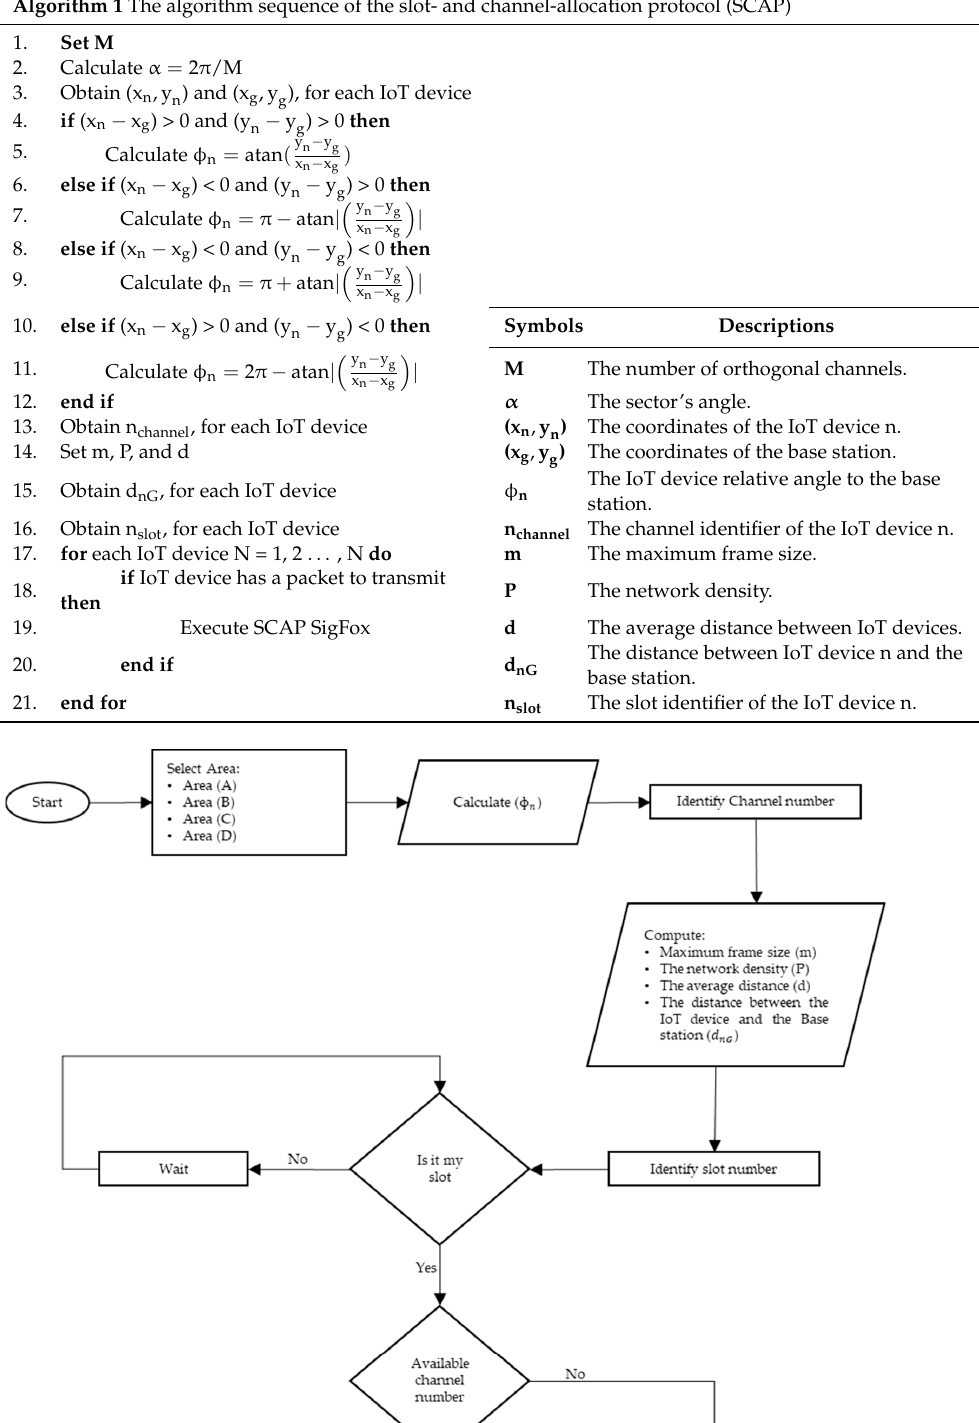
Algorithm 1 The algorithm sequence of the slot- and channel-allocation protocol (SCAP)